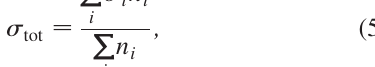
FIG. 5. (Color) Activity of the stainless-steel beam pipe induced by 1 W = m of primary beam loss at 1 GeV = u (upper) and 200 MeV = u (lower). The relative standard uncertainty of the data points ranges from 0.05% to